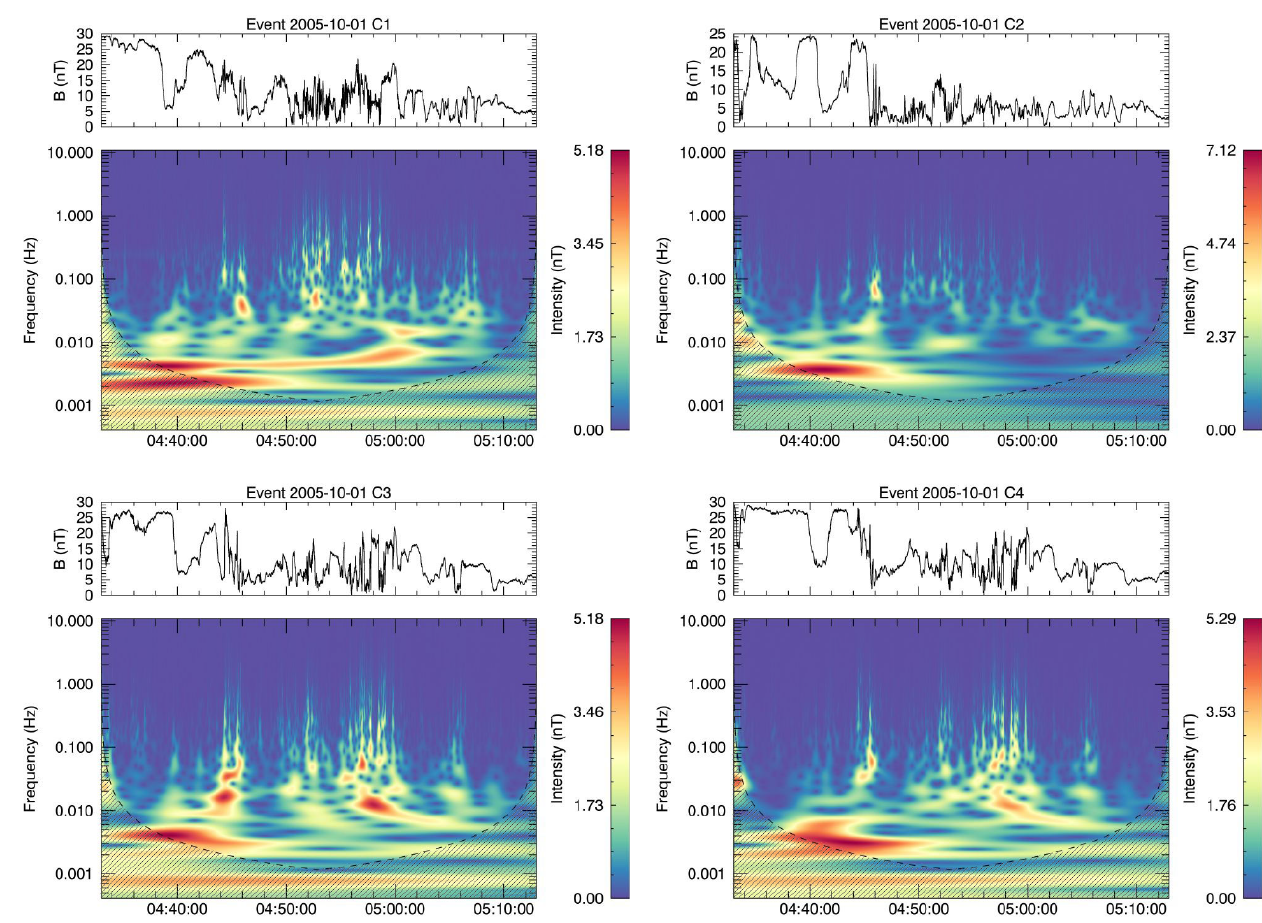
Figure 6. The results of wavelet analysis for event 1 October 2005. The cone of influence is shown by the shaded region.